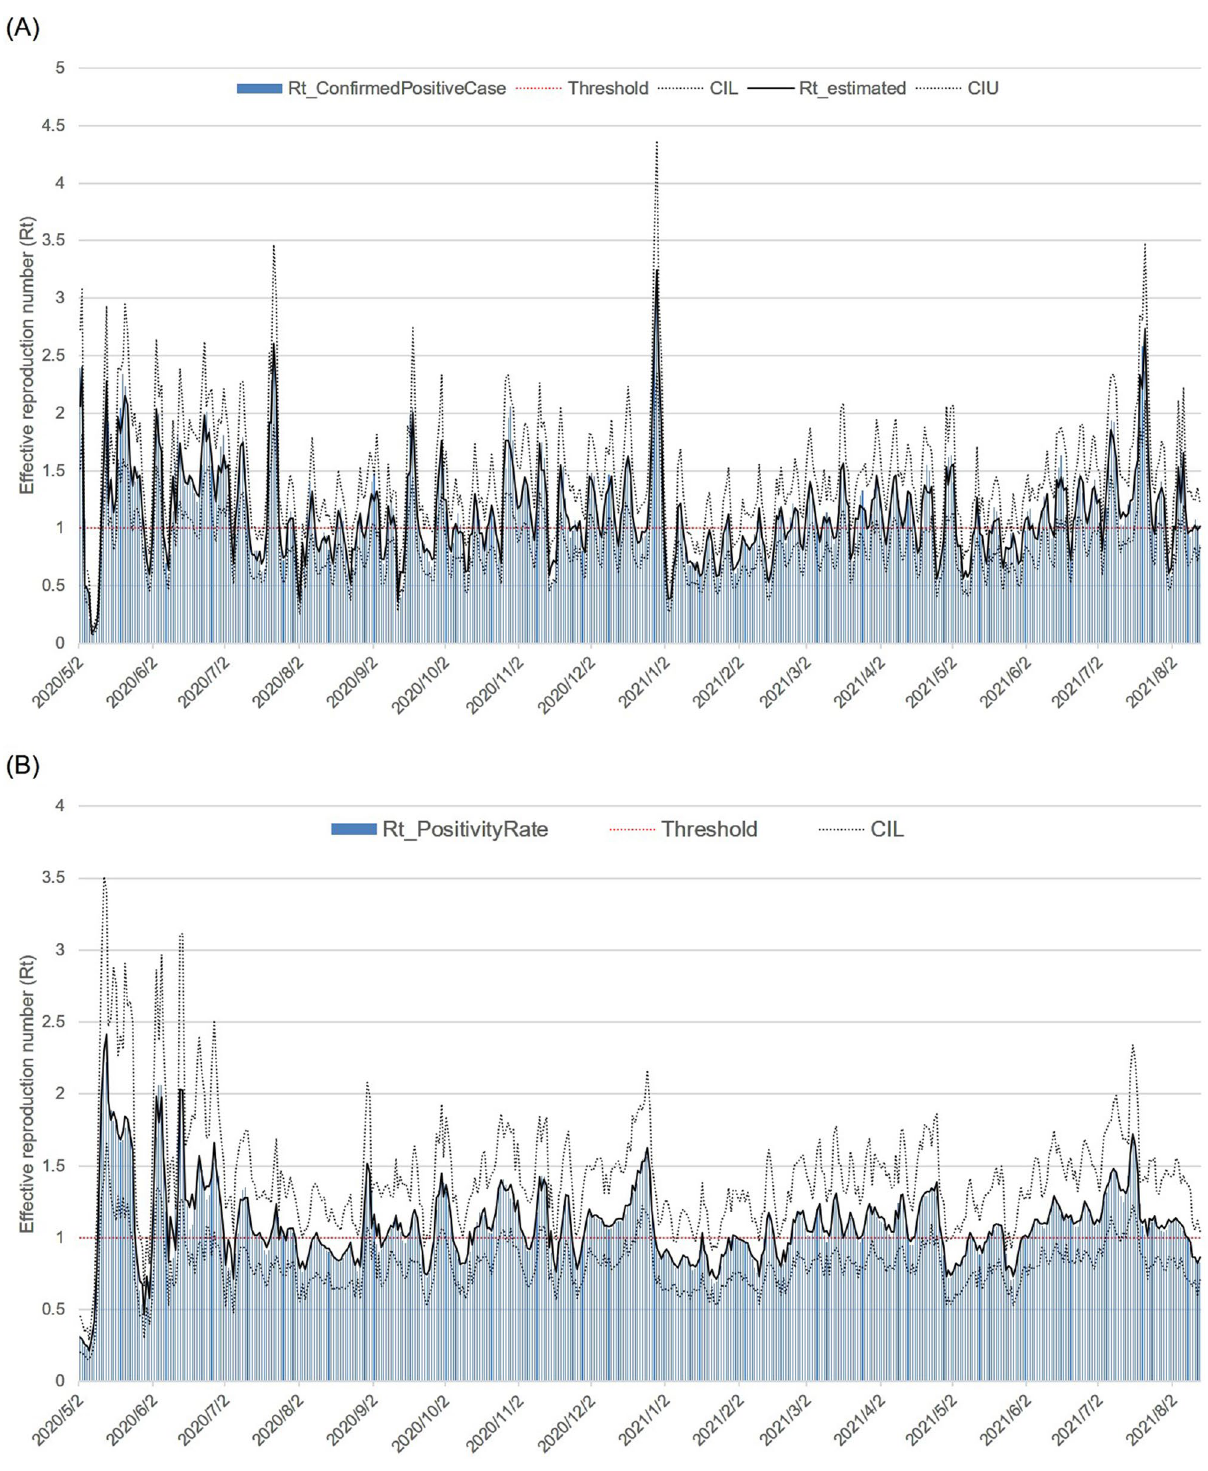
Figure 5. Estimates obtained by applying Eq. (2) to the number of people and effective reproduction number. The fit between the effective reproduction number ( R t ) and the estimate obtained by Eq. (2) is shown. In ( A ), all values were estimated using the number of confirmed positive cases. The R t estimated by Eq. (1) (blue bar), the threshold for both the R t (1.0) (red dotted line), the R t estimated by Eq. (2) (black line), the lower 95% credible interval limit of the R t estimated by Eq. (2) (95% CIL) (black dotted line), and the upper 95% credible interval limit of the R t estimated by Eq. (2) (95% CIU) (black dotted line) are shown. The only difference between ( A, B ) is that all values were estimated using the positivity